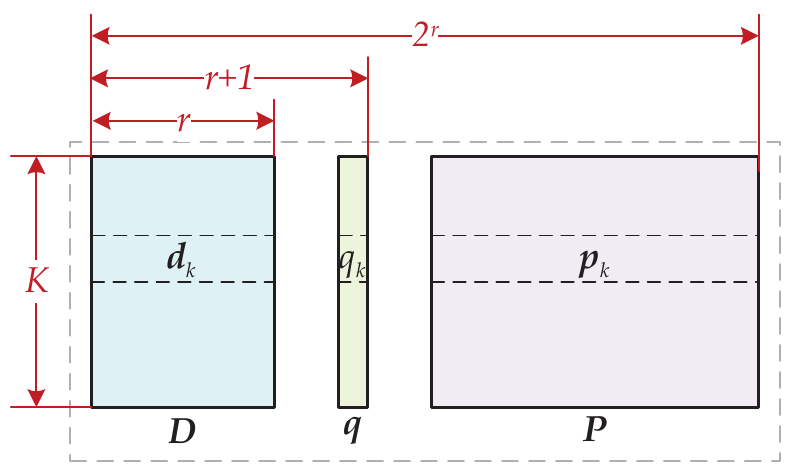
Figure 3. Structure of component tail-biting convolutional-Hadamard codes.